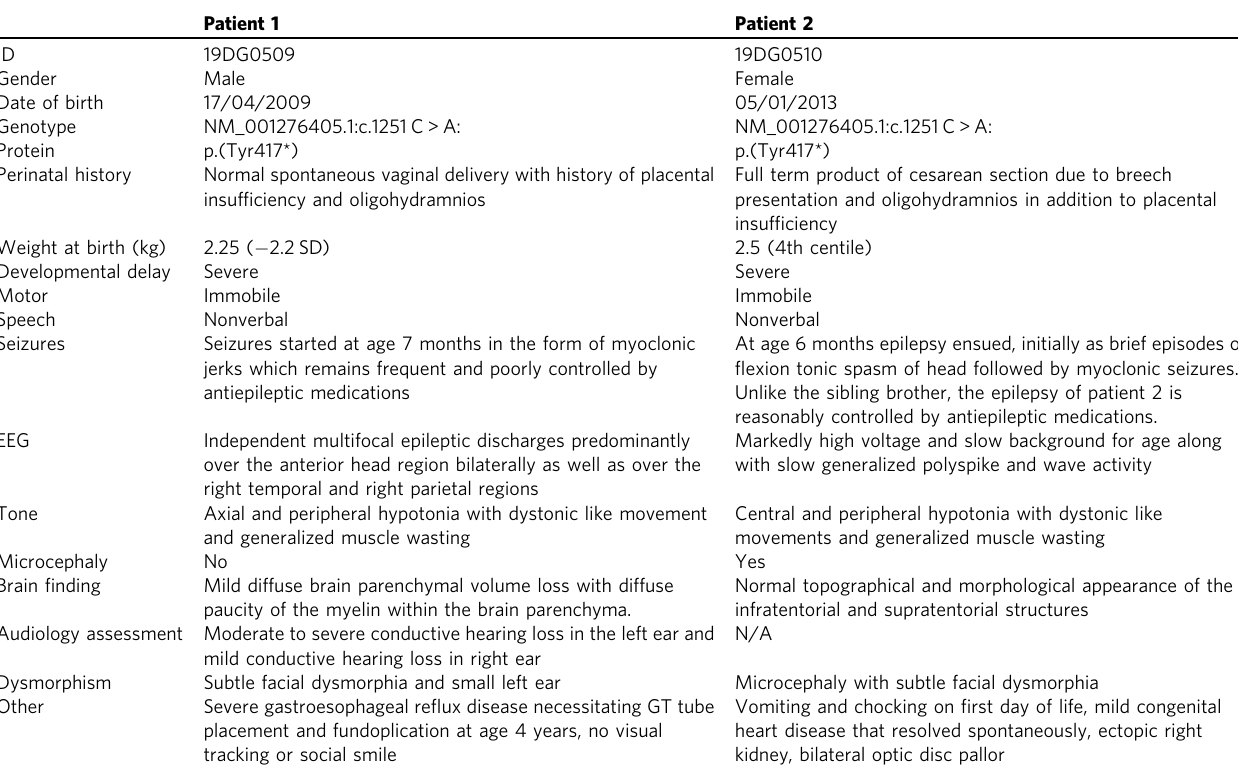
Table 1 Clinical phenotype and molecular fi ndings for patients with homozygous variants in